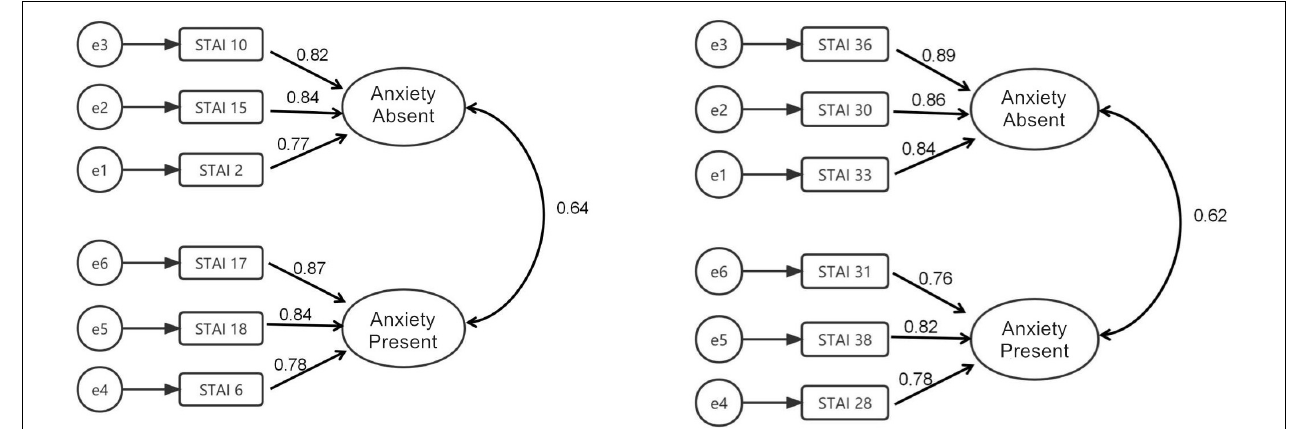
FIGURE 2 | The confirmatory factor analysis model of STAI-S-6 and STAI-T-6.